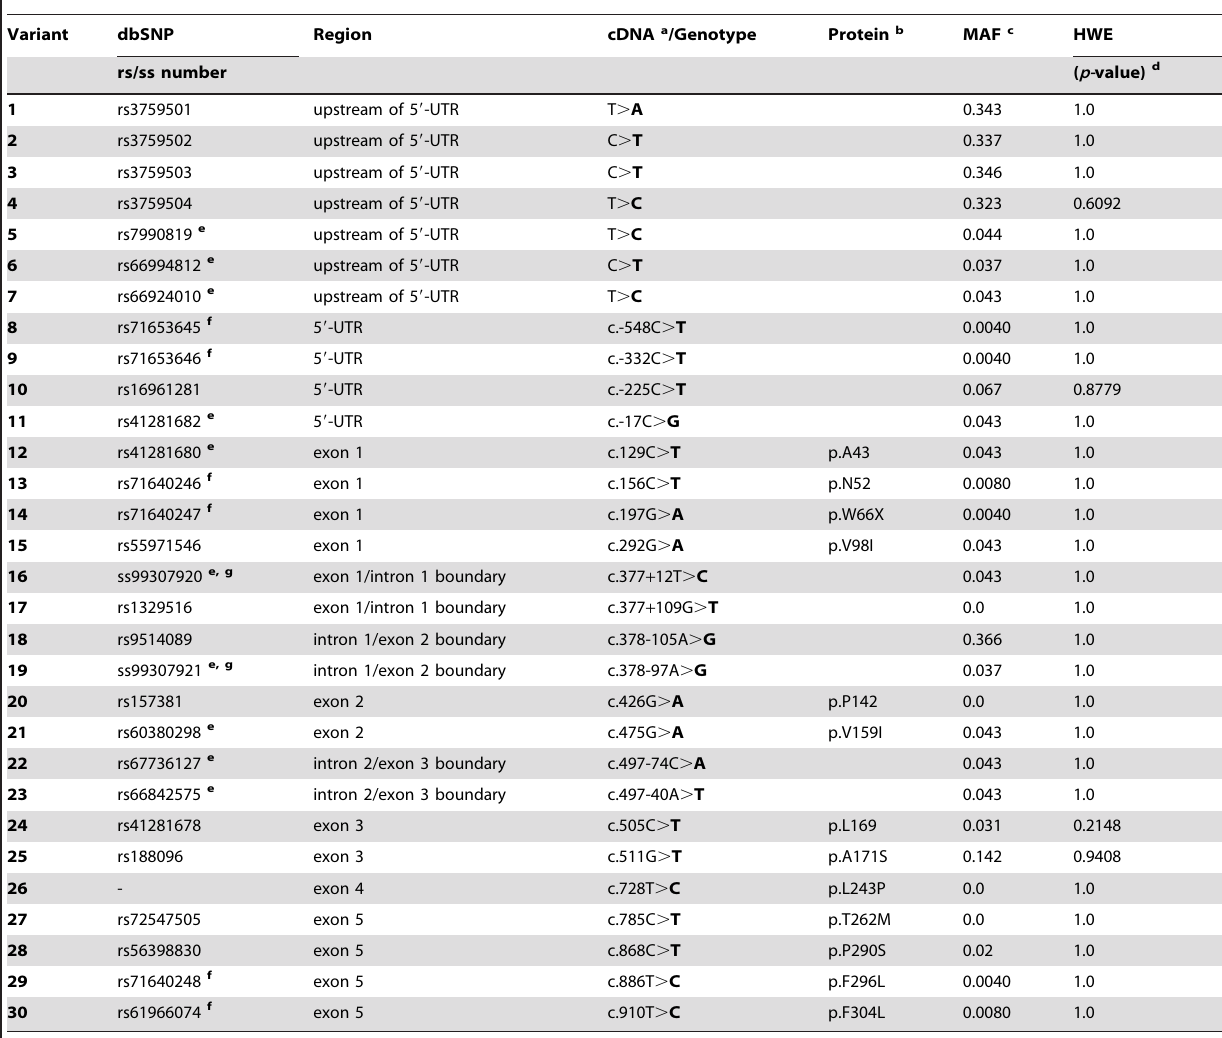
Table 1. Main characteristics of all 30 SNPs examined in the Stuttgart